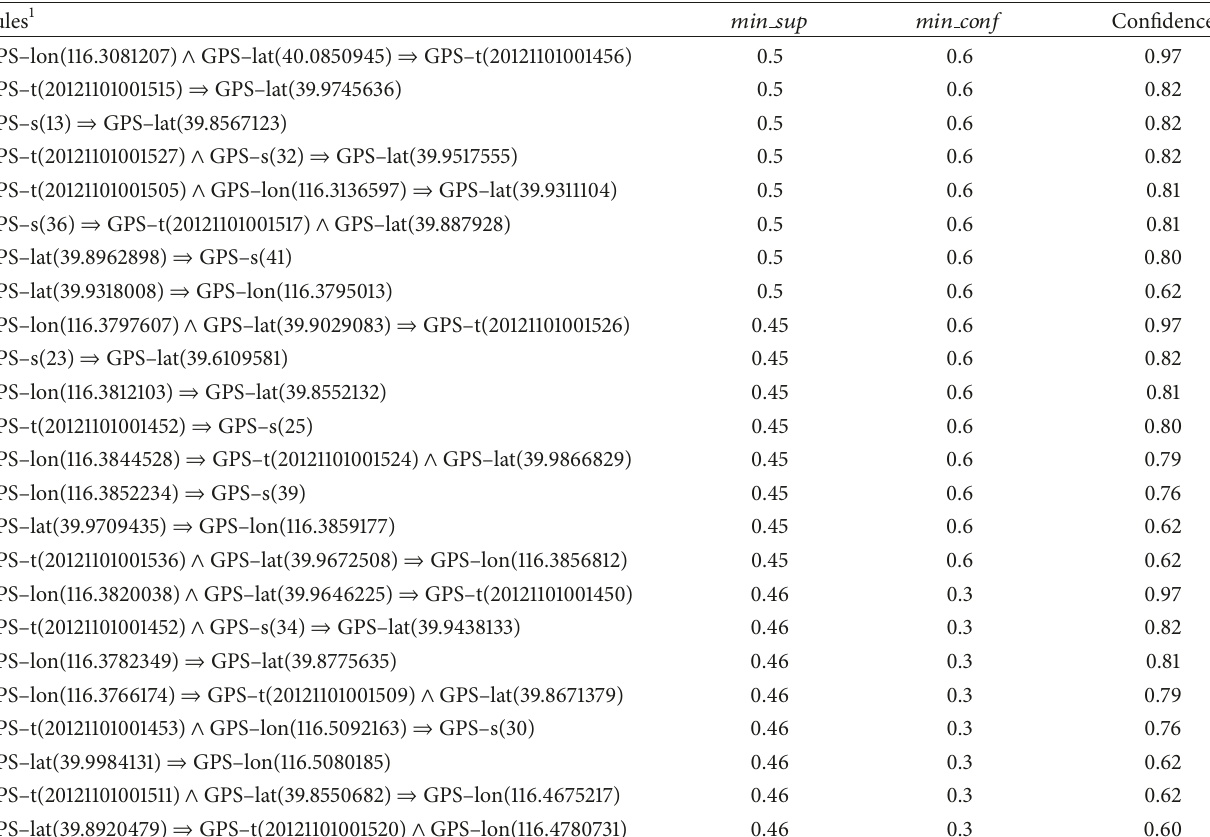
Table 2: Association rules in the spatiotemporal